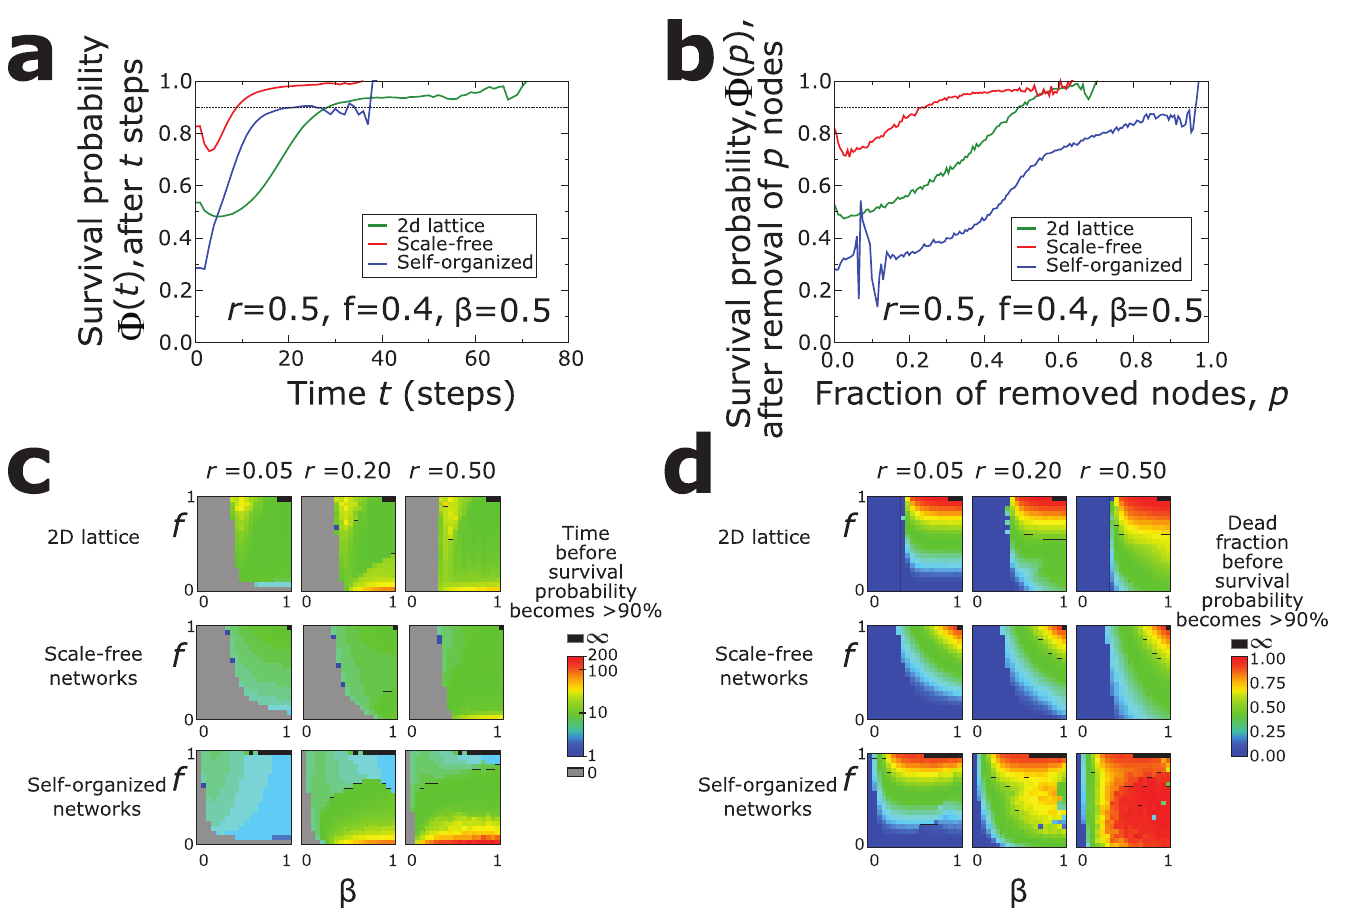
Fig 5. Survival probability. (a) Average survival probability for a node that has survived after t steps as a function of t . The lines correspond to the three different topologies, for a given set of parameter simulations. (b) Average survival probability for a node that has survived after a fraction, p , of nodes has died of the disease. (c) The time t 0.9 for different parameters r , f , and β . (d) The fraction p 0.9 for different parameters r , f , and β . Combination of the results on dead population and